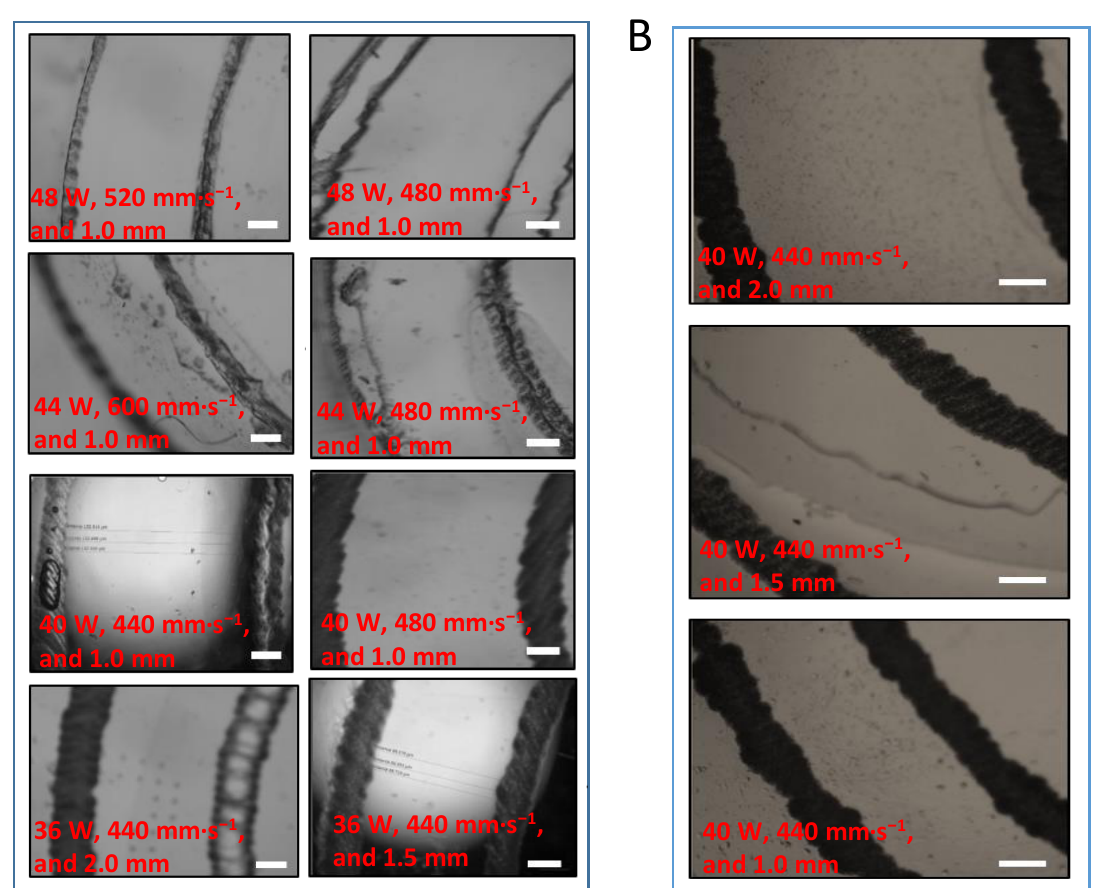
Figure 3. Images of the laser-treated contact lenses captured by an optical microscope. ( A ) images of all the laser-treated lenses at different laser operation conditions; ( B ) images of the contact lenses having different spacing gaps between the microchannel and were operated under the same conditions.